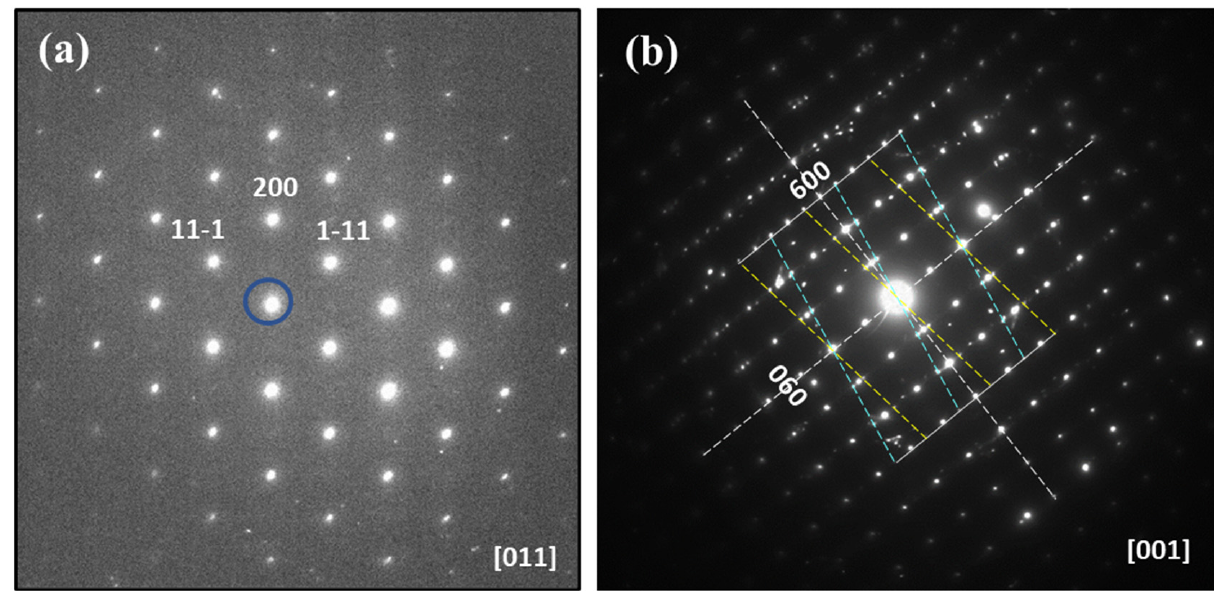
Figure 8. SADP’s of ( a ) clear (C) [011], (beam marked by O ) and ( b ) faulted (F) [001] YSZ grains (from Figure 7a,b), the latter showing many extra reflections probably related to variants of t” domain orientation. In ( b ), the parent phase is shown as an orthogonal grid of {200} reflections. Extra reflections appear to arise from two twin variants, marked by the yellow and aqua dashed grids, slightly off-zone. The trace of possible twin habit planes, shown as orthogonal [200] and [020] axes (a 0 for YSZ is 5.1 Ả for the cubic parent phase and indistinguishable from tetragonal).